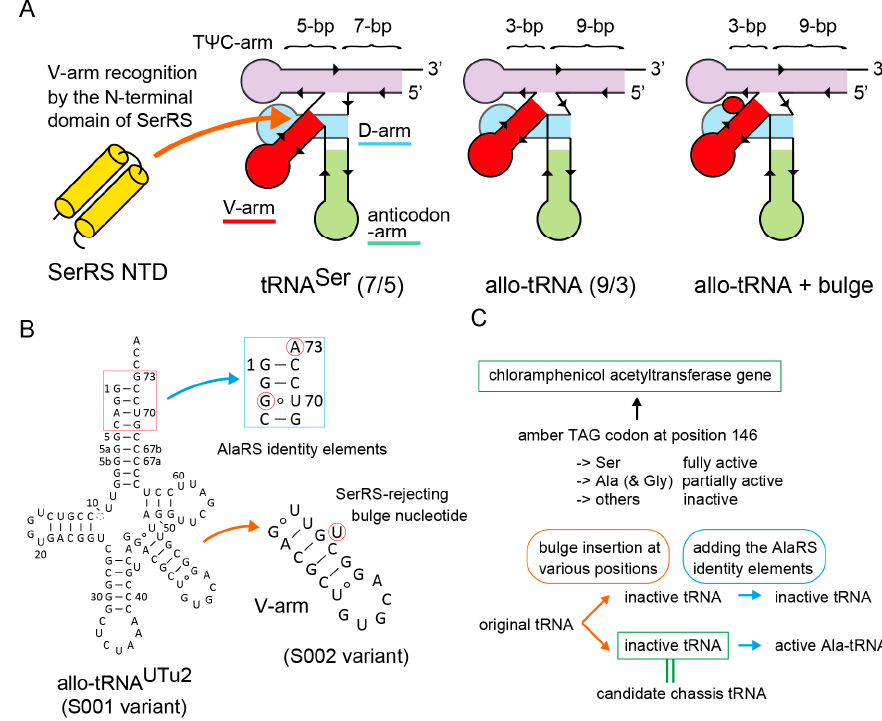
Figure 1. Strategy for tRNA chassis development. ( A ) Design of a new tRNA chassis derived from a few allo-tRNA species having the 9/3 composition. Compared to the E. coli tRNA Ser having the canonical 7/5 composition, (9/3) allo-tRNA molecules may have a smaller space for the binding of the N -terminal domain (NTD) of SerRS. Thus, it was assumed that the interaction between SerRS and allo-tRNA molecules could be sterically hindered by the insertion of a bulge (flipped-out) nucleotide into the stem region of the V-arm. ( B ) A preliminary result suggested that the allo-tRNA UTu2 variant containing the bulge U was a poor substrate for SerRS, while its variant having the AlaRS identity elements was active for Ala-tRNA regardless of the bulge U insertion. ( C ) Experimental design for screening candidate chassis tRNAs by using a reporter gene in E. coli .